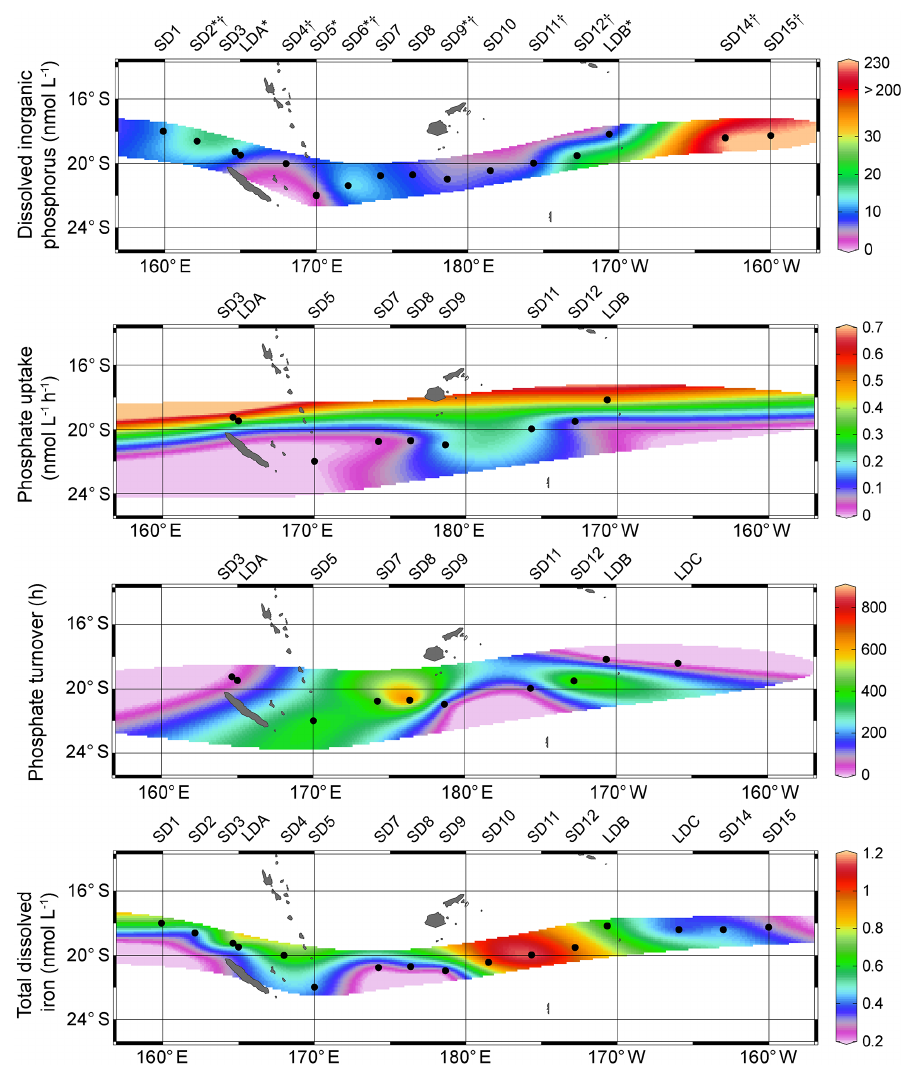
Figure 1. Surface water column dissolved inorganic phosphorus (DIP) concentration, community phosphate uptake rate, community phos- phate turnover, and total dissolved iron concentration measured at stations across the OUTPACE (Oligotrophy to UlTra-oligotrophy PACific Experiment) transect during austral summer (February–April) of 2015. All samples were obtained from 10m depth, with the exception of the DIP measurement from LDA and the DFe measurement from SD12 (30m). Numbers above and below indicate the short-duration (denoted SD) or long-duration (denoted LDA, LDB, or LDC) stations where samples were obtained across the transect. In the top panel, ∗ indicates stations where metagenomic or metatranscriptomic samples were obtained and † indicates stations where Trichodesmium clade distribution samples were